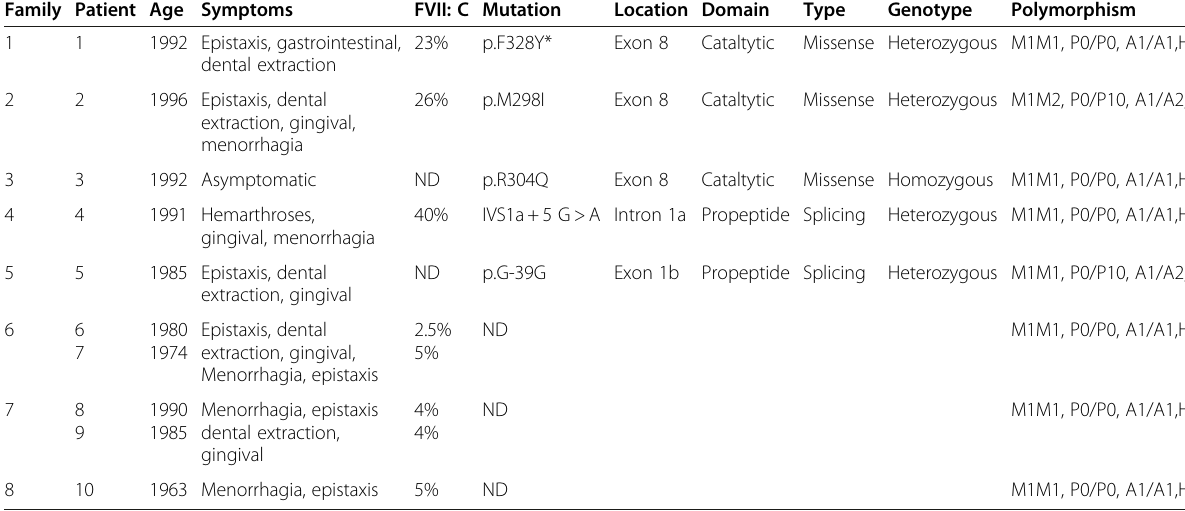
Table 1 Phenotype and genotype data of Tunisian patients with FVII deficiency Family Patient Age